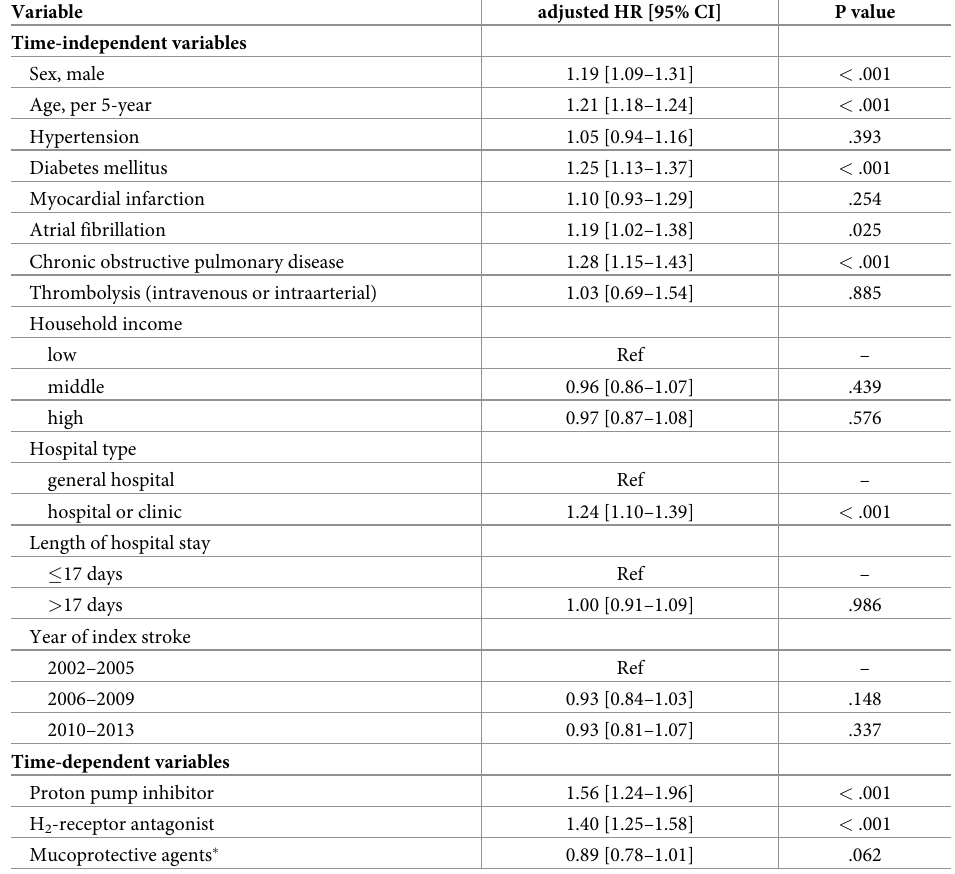
Table 3. Effects of medications on the risk for post-stroke